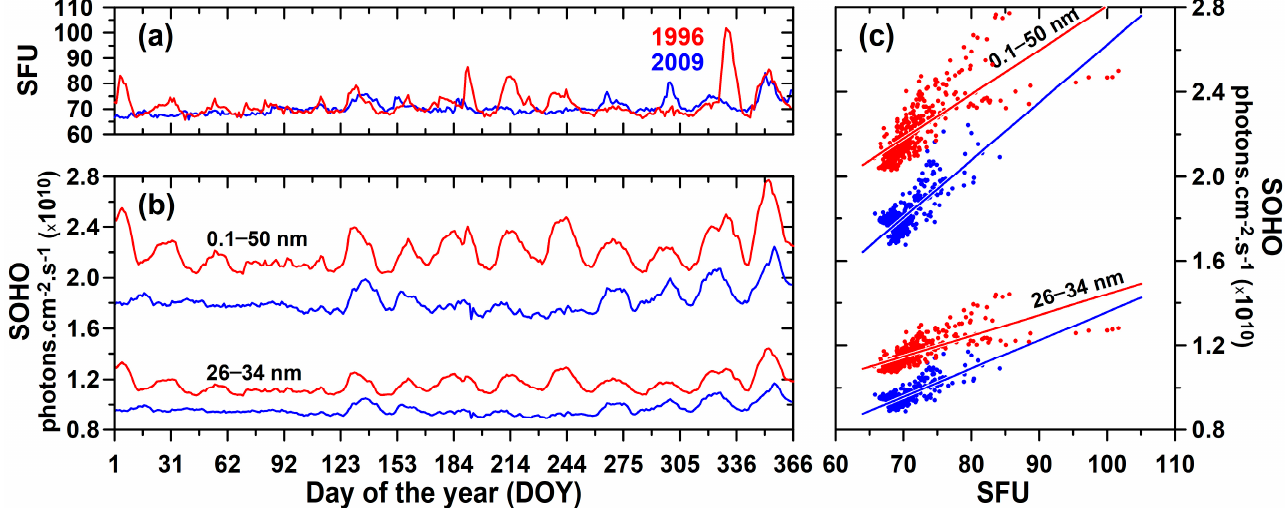
Figure 1. Solar activity representation based on the decimetric solar flux (F10.7 cm) (panel ( a )) and the 26–34 nm and 0.1–50 nm EUV bands data measured by the Solar EUV Monitor onboard the Solar Heliospheric Observatory (SOHO) (panel ( b )). Panel ( c ) shows the linear regression fitting over the two SOHO bands with respect to F10.7 cm. The red and blue colors represent the 1996 and 2009 solar minimums, respectively.